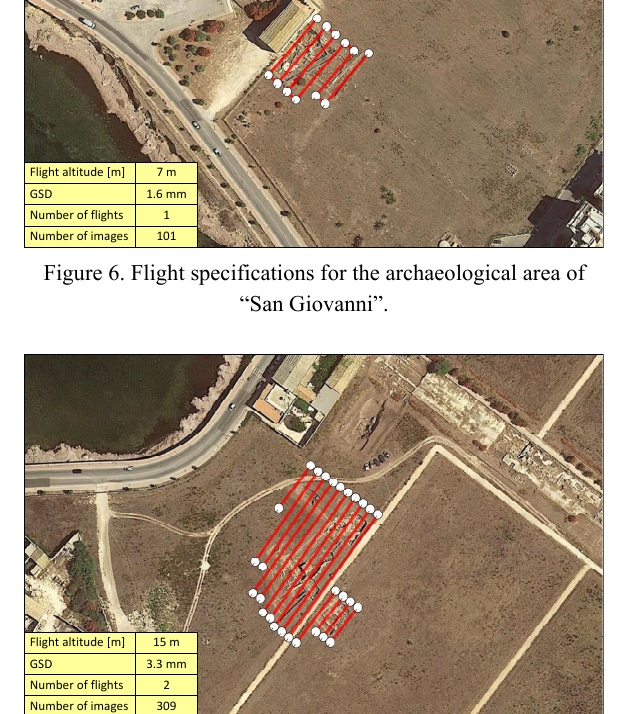
Figure 7. Flight specifications for the area of north-western fortifications and thermal baths.